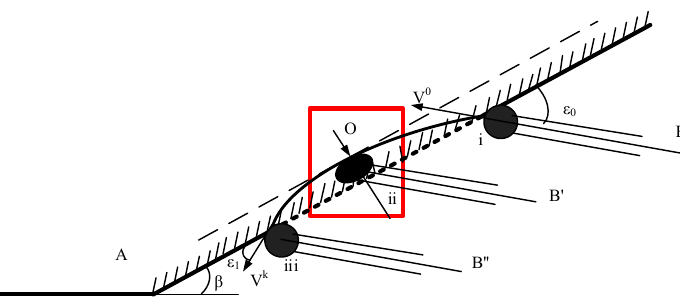
Figure 2. Transient collision of docking connectors with an elastic pin head engaging with an elastic inner-wall of a chamfered hole.